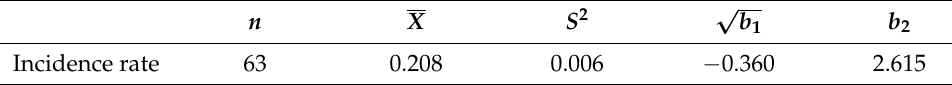
Table 4. Descriptive statistics for data in Application 1.